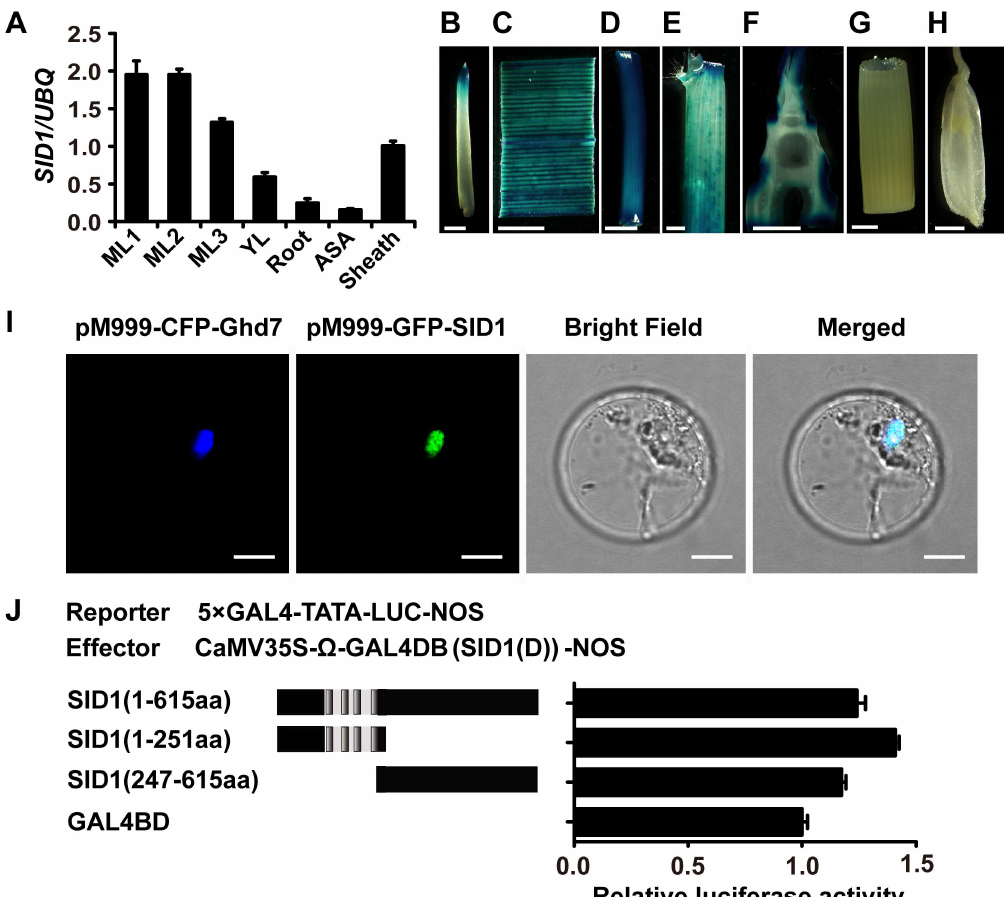
Fig 4. Expression patterns of SID1 and its transcriptional activation. (A) Transcript levels of SID1 in the indicatedorgans at seedlingstage. The data are means ± SEM of three independentexperiments. (B–H) GUS staining(blue) of distinct organs in pSID1 :: GUS transgenic plants: (B) root; (C) expandingleaf; (D) young leaf; (E) sheath; (F) longitudinalsection of the shoot apical meristem; (G) stem; (H) floret. Scale bar, 2 mm. (I) Subcellular localization of SID1. Full-lengthSID1 fused with green fluorescent protein (GFP); the nuclear protein Ghd7 fused with cyan fluorescent protein (CFP) served as a nuclearmarker. The two proteinswere co-expressed in rice protoplasts. A bright-fieldimage and the mergedimage are shown on the right. Scale bar, 10 μ m. (J) Relative luciferase activities of rice protoplastsco-transfected with reporter and distinct effectors. Schemes of deletion mutants of SID1 are shown at left. Gray bars in the N-terminal regionof SID1 indicate four zinc finger motifs. All luciferase activities are expressedrelativeto the value of GAL4 BD alone. Values represent means of three independent